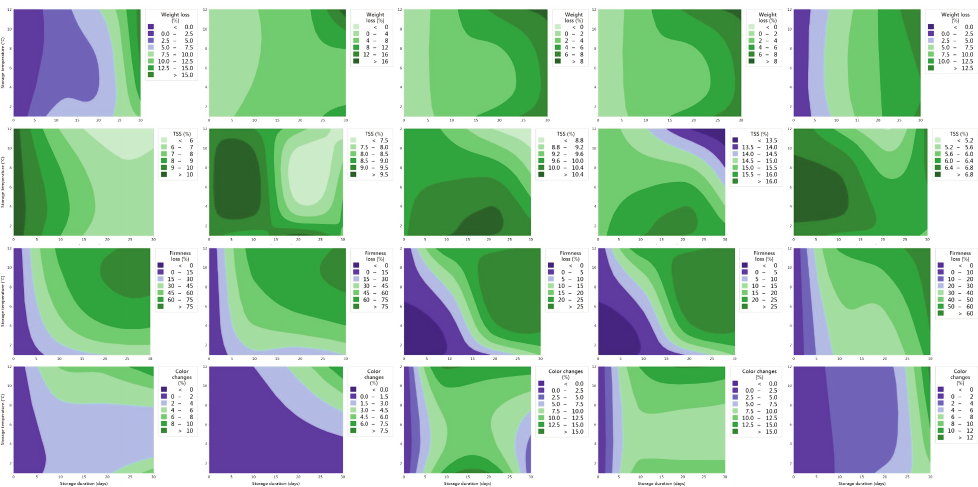
Fig. 5 ­ Contour plots of postharvest changes during cold storage period for the studied hybrids. Each column of contour plots repre­ sents a hybrid (From left to right ‘Cm­UTKHA’, ‘Cm­UTAKH’, ‘Cm­UTKHJ’, ‘Cm­UTJKH’, and ‘Cm­UTZKH’, respectively). Each row of contour plots represents a postharvest attribute (From top to bottom Weight loss, TSS, Firmness loss, and Color changes, respec­ tively). A significant difference between contour levels is present when the difference between contour levels are larger than 1.32, 1.67, 5.97, and 1.02 for Weight loss, TSS, Firmness loss, and Color changes, contours respectively